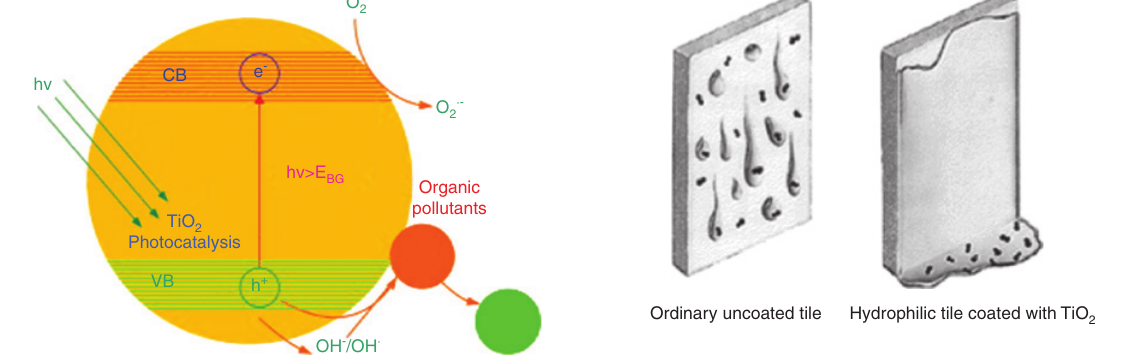
Figure 7: Illustration of uncoated and coated tile with a hydrophilic TiO layer. Reprinted with permission from Ref. [75]. Copyright 2012 2 Multidisciplinary Digital Publishing